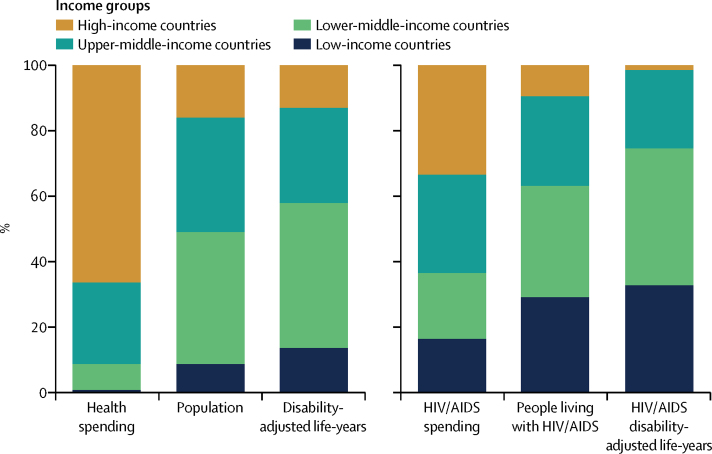
Spending, population size, and disability-adjusted life -years overall and for HIV/AIDS, by income group, 2015Income groups are 2017 World Bank income groups.